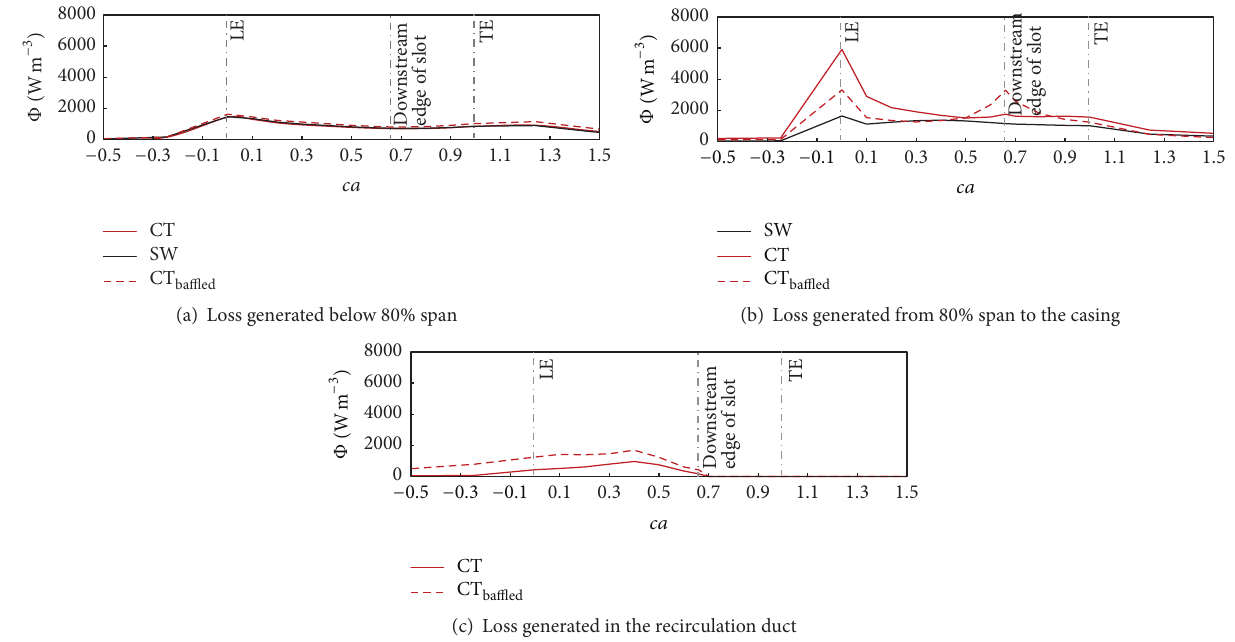
Figure 6: Stream-wise distribution of loss generation at peak efficiency point ( 𝑚 = 4.2